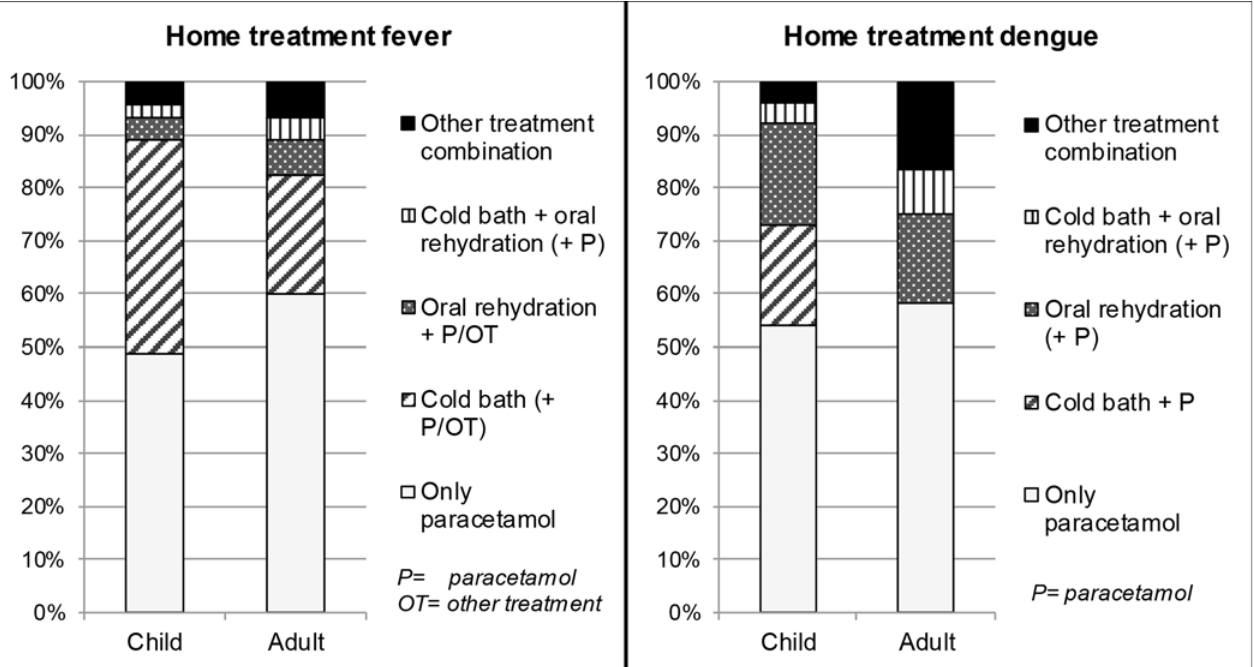
Fig 2. Home treatment choices for fever and dengue. The percentages correspond to their contribution to those who mentioned to treat at home when answering the adult questionnaire (fever: n = 45; dengue: n = 12) or the child questionnaire (fever: n = 45; dengue: n = 26).The categories of treatment combinations in fever and dengue are equal in meaning. However, reporting to treat at home with ‘ paracetamol ’ (P) and ‘ other treatment ’ (OT) varies between the categories of home treatment of fever and dengue. P and OT are placed within brackets if not all subjects within the category used additionally P or OT. OT may refer to the following: rubbing the body with alcohol/cream, body sponging, aspirin, other medication or rest.